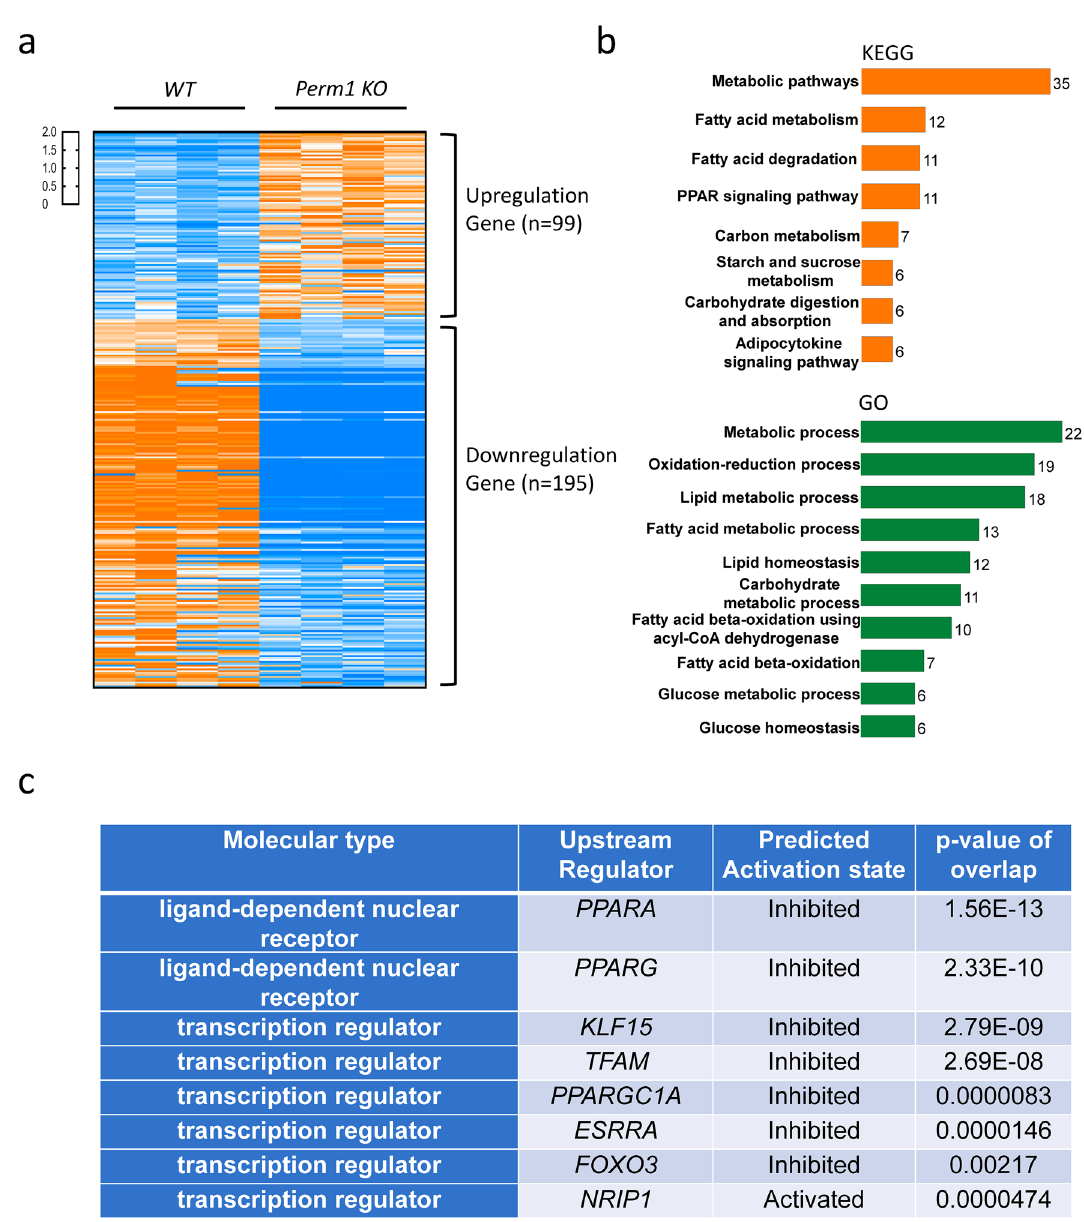
Figure 3. PERM1 regulates genes involved in metabolism in the mouse heart. ( a ) Illumina-based RNA-seq showing genes differentially expressed in Perm1 KO mice and WT mice, including 99 upregulated genes and 195 downregulated genes (n = 4/group, all male, 2 months old, The statistical significance was determined with Student’s t test, *p < 0.05 was considered significant. cantly regulated genes showed that the pathway and protein function affected in Perm1 KO mice is metabolism. ( c ) Transcription factor analysis by Ingenuity Pathway Analysis (IPA, Qiagen Inc). The significant p-value indicates likely inhibition or activation states of an upstream regulator in Perm1 KO mice compared with WT